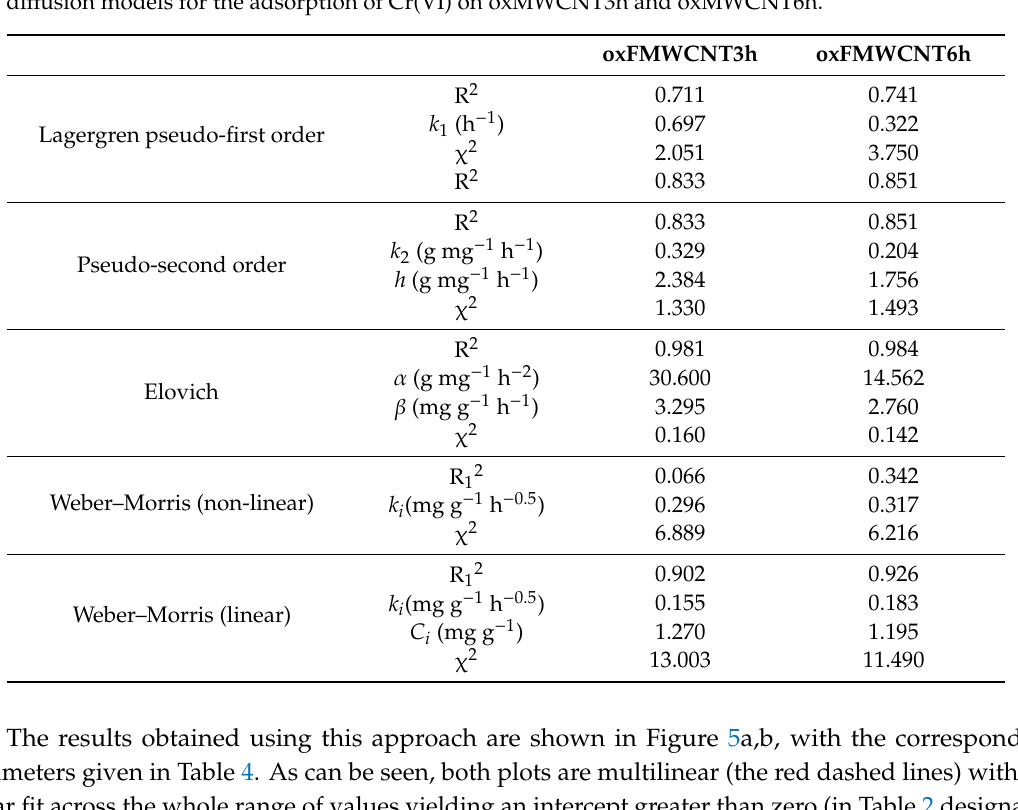
Table 4. Parameters of Lagergren pseudo-first order, pseudo-second order, Elovich and intra-particle di ff usion models for the adsorption of Cr(VI) on oxMWCNT3h and oxMWCNT6h.